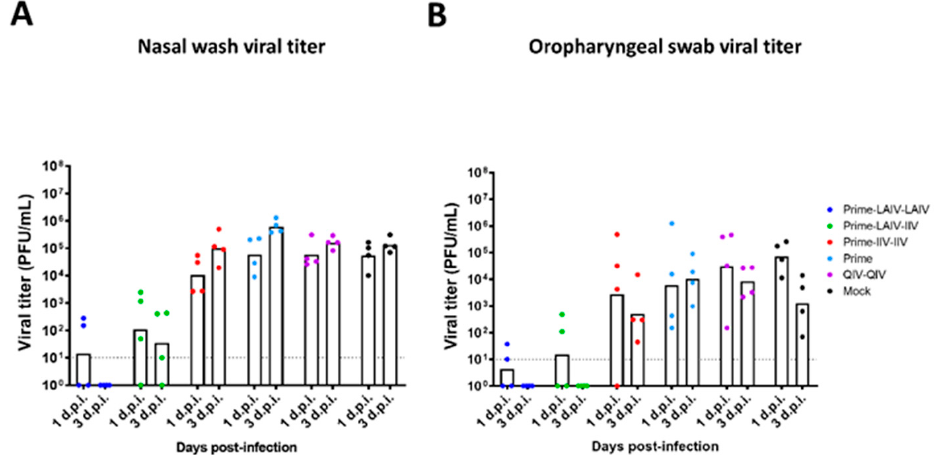
Figure 5. Viral shedding in upper respiratory tract after pH1N1 virus challenge infection. Viral titers for the vaccinated or mock-vaccinated animals were measured by plaque assays. ( A ) Nasal wash and ( B ) Oropharyngeal swab viral titers were measured on days 1 and 3 post-infection with H1N1 influenza A virus. LAIV-LAIV, LAIV-IIV, IIV-IIV, Prime-only, and QIV-QIV vaccinated animals are shown as blue, green, red, light blue, and purple, respectively. Mock-immunized animals are shown as black. All animals except for QIV- and mock-immunized ferrets were primed with B-cH9/1 virus. White bars denote the GMT with individual scatter dot plots. Each point indicates the titer for each individual ferret ( n = 4/group). The black dashed line indicates the limit of detection for the assay. Data were analyzed by two-way ANOVA followed by a Tukey’s multiple comparison test (multiple time points).